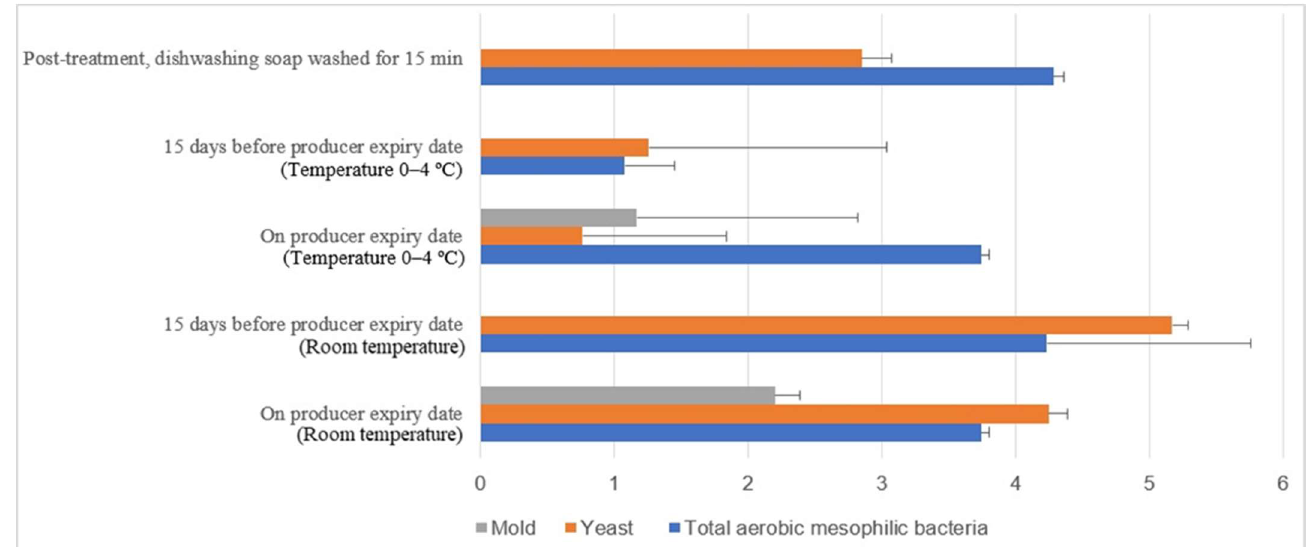
Figure 15. Microbial load (log10 CFU/cm 2 ) during storage at room and chill temperature after washing with dishwashing soap.